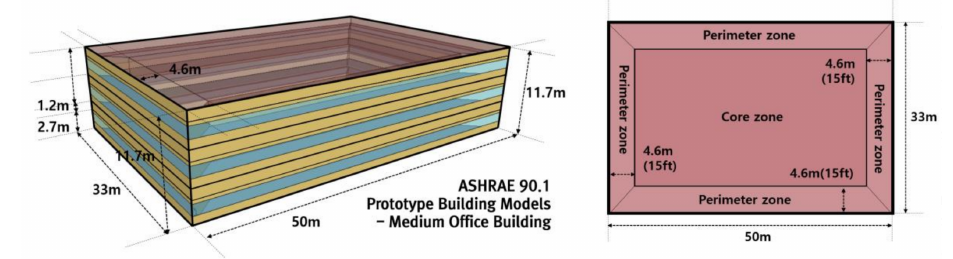
Figure 9. Simulation base model.